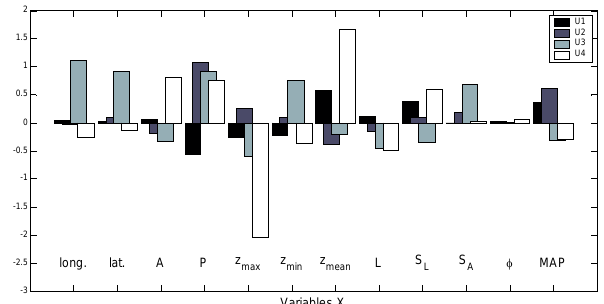
Fig. 4. Coefficients of the linear transformation for the canonical variables of the X